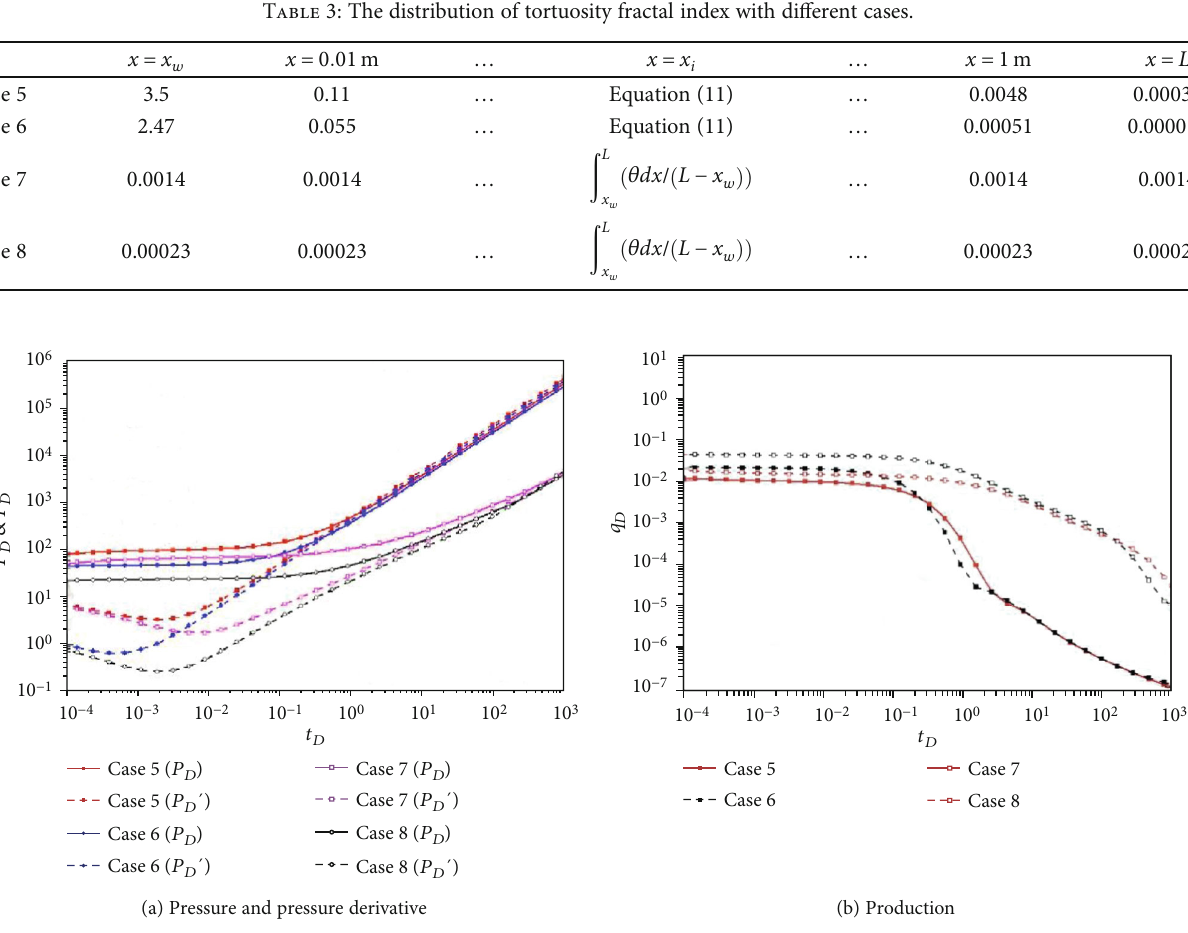
Figure 4: In fl uence of tortuosity fractal index on pressure and